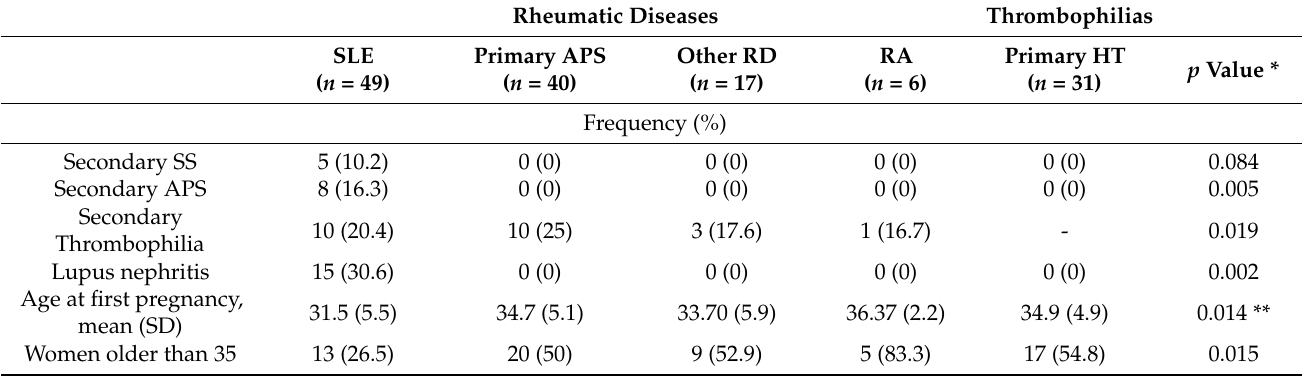
Table 2. Baseline characteristics of women treated at an MC by type of